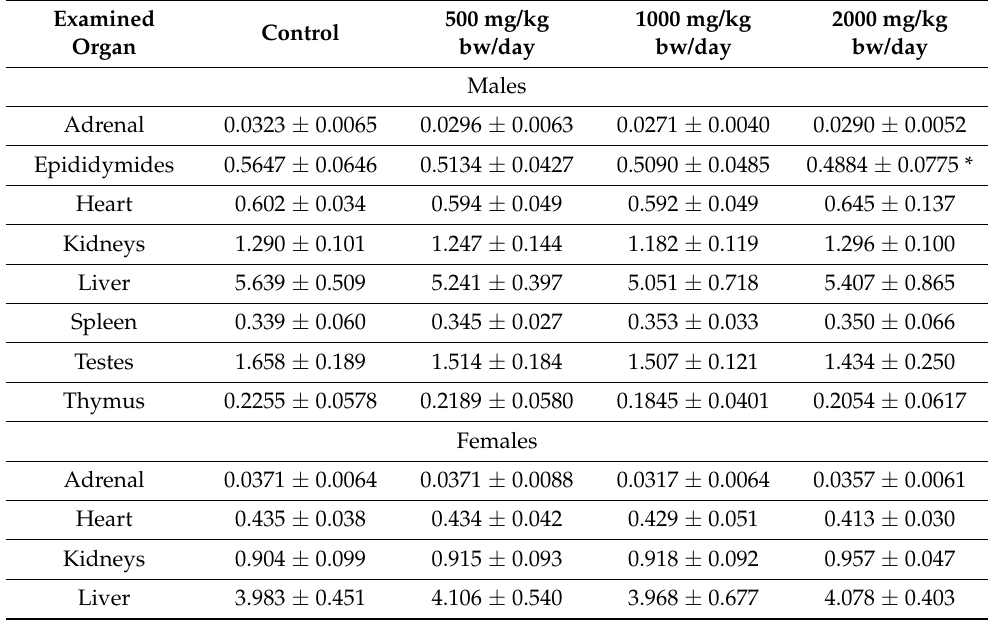
Table 8. Organ-to-brain weight